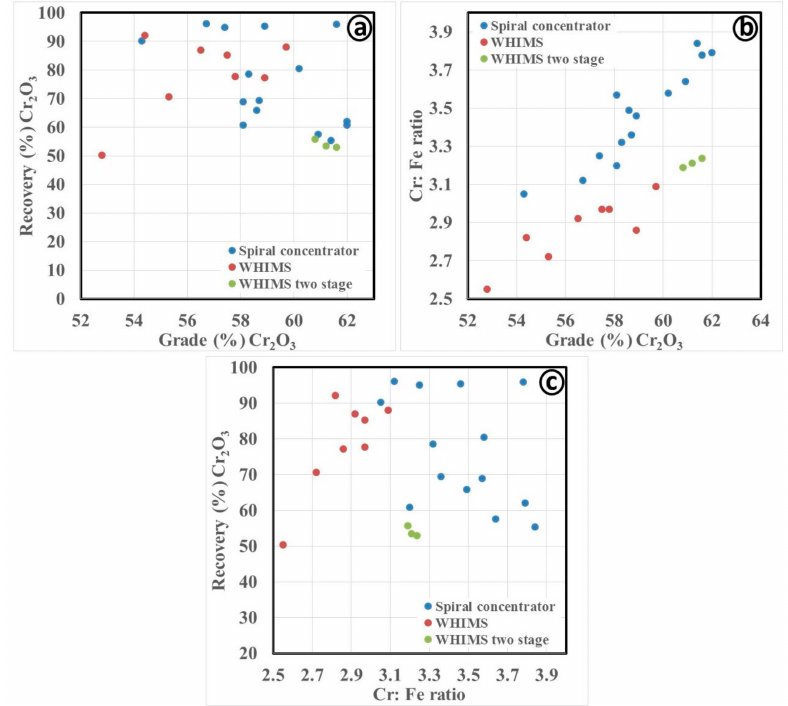
Figure 16. Comparison of the performance of the spiral concentrator and the WHIMS in treating fine concentrate ( a ) for grade and recovery; ( b ) for grade and Cr:Fe rato; ( c ) for Cr:Fe rato and